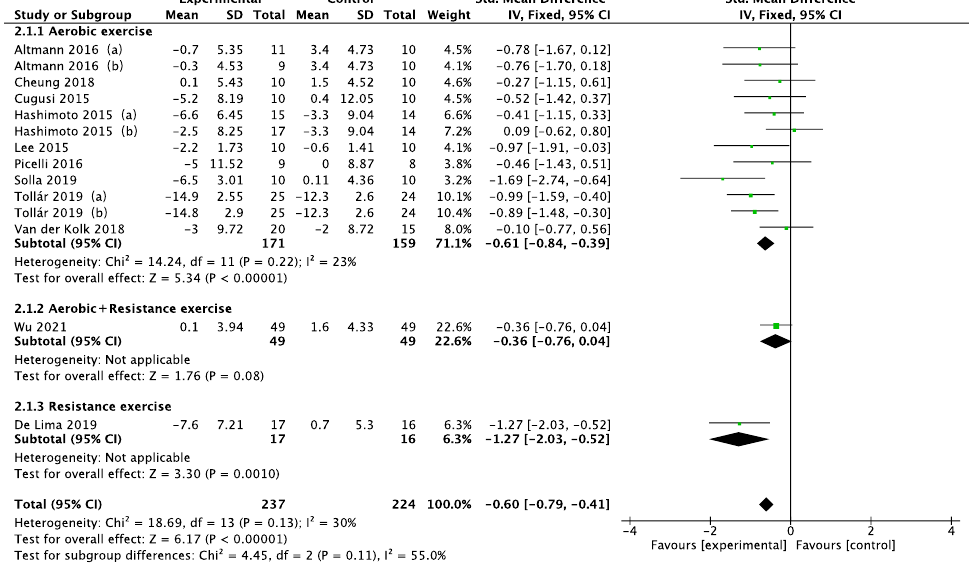
Figure 6. Subgroup analysis of intervention type [24,25,33 – 41].